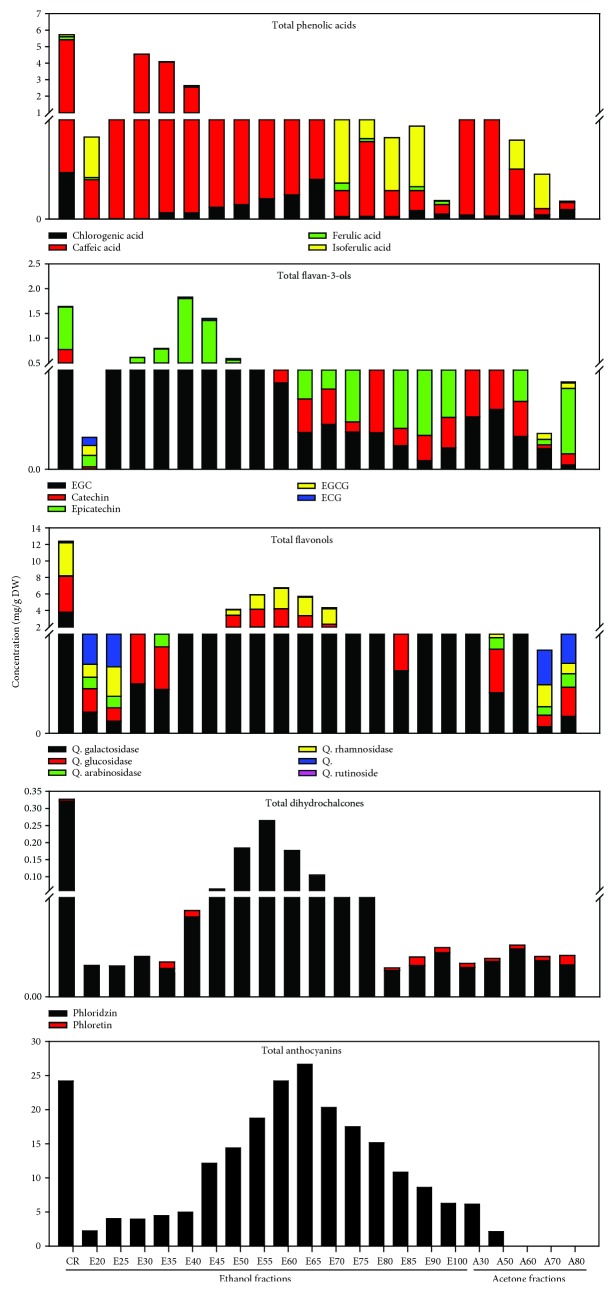
Characterization of different cranberry pomace fractions by UPLC-ESI-MS. Flavan-3-ols are represented by the sum of catechin, epicatechin, EGC, ECG, and EGCG. Phenolic acids are a sum of chlorogenic, ferulic, and caffeic acids. Flavonols are a sum of quercetin glucoside and galactoside; Dihydrochalcones represent the sum of phloridzin and phloretin. Anthocyanins represent cyanidin-3-O-glucoside, the most predominant anthocyanin.